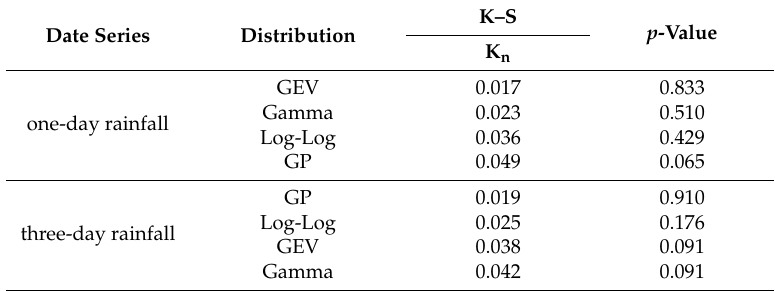
Table 2. Test statistics for the fitted cumulative distribution for one-day and three-day rainfall.